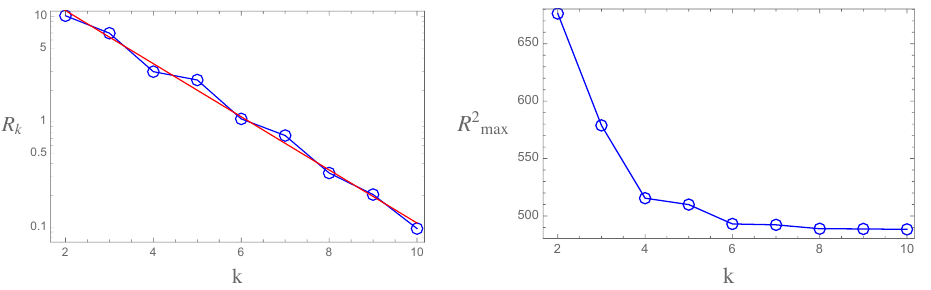
Figure 5 . The maximum Ricci scalar (left) and magnitude of the curvature squared invariant (right) on the points sampled for the Fermat quintic threefold in P 4 as a function of k . The Ricci scalar approaches zero exponentially as k is increased while the higher curvature invariant approaches a (cid:12)xed value.